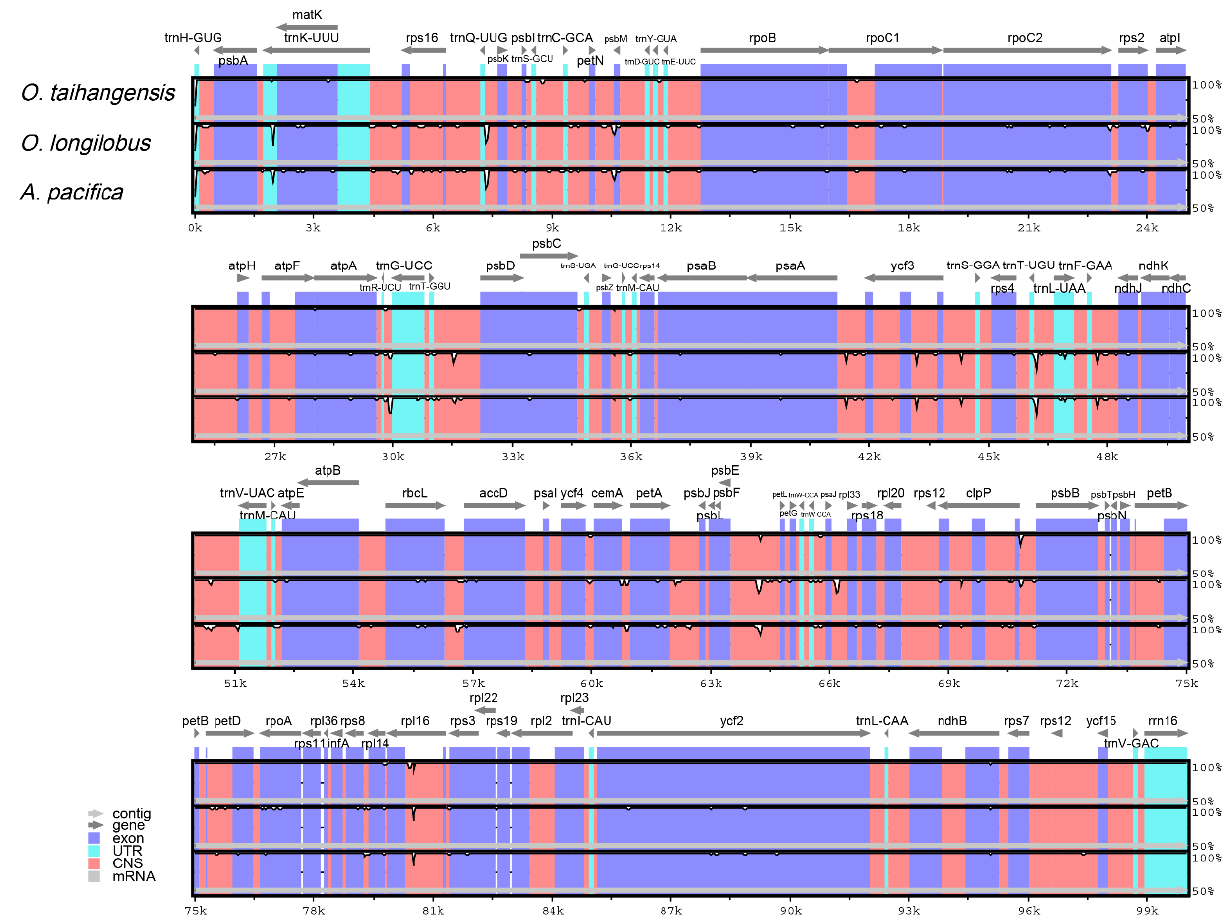
Figure 7. Comparison of four chloroplast genomes using O. taihangensis (NC_042787) annotation as a reference. The vertical scale indicates the percentage of identity, ranging from 50 to 100%. The horizontal axis indicates the coordinates within the chloroplast genome. Genome regions are color-coded as exons, introns, and intergenic spacer (IGS).